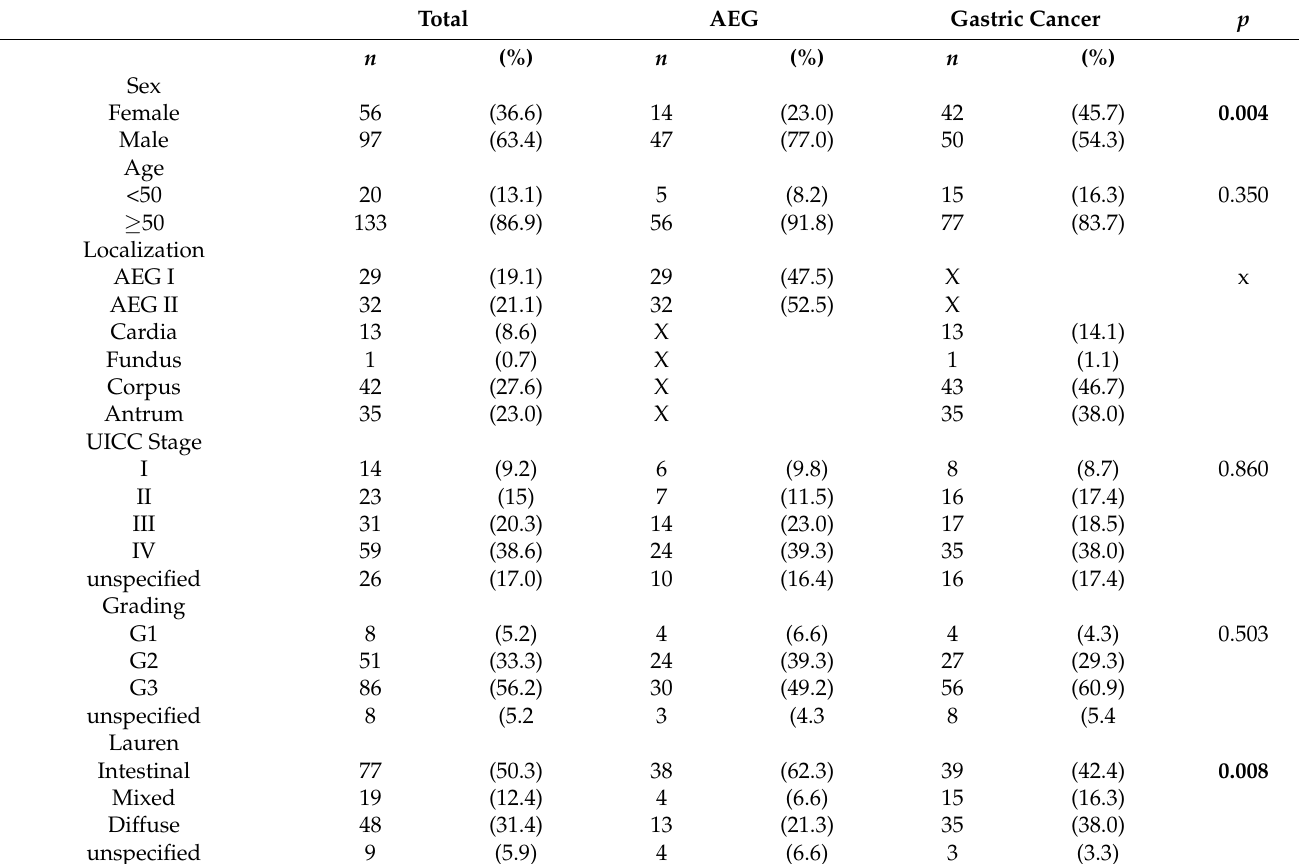
Table 1. Patient